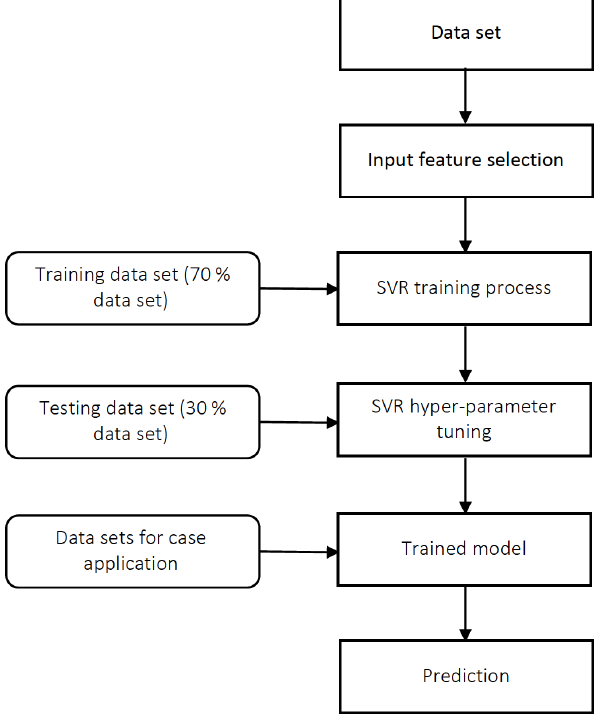
Figure 5. Procedure for support vector regression (SVR).